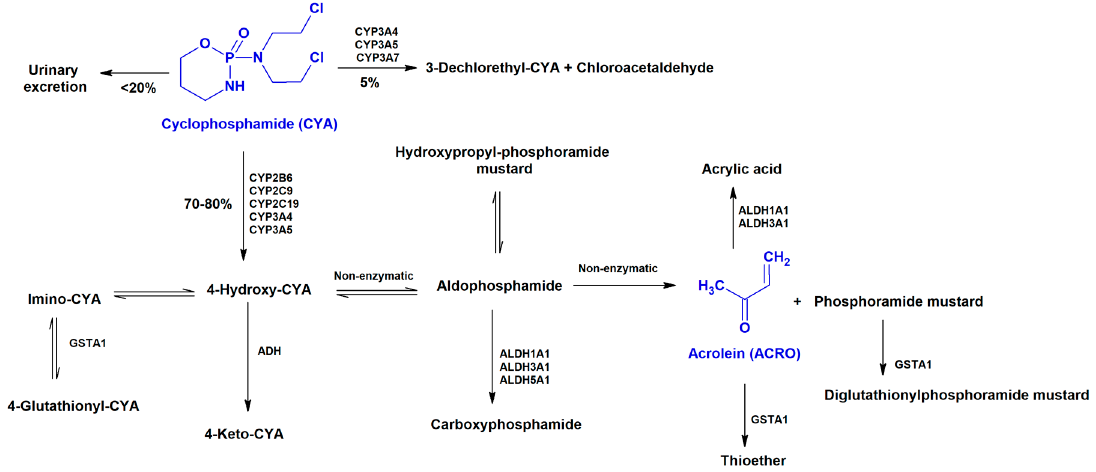
Figure 3. Metabolism of cyclophosphamide (CYA) [33,46,54,55]. CYP: Cytochrome P450; GST: Glutathione S-transferase; ALDH: Aldehyde dehydrogenase; ADH: Alcohol dehydrogenase.